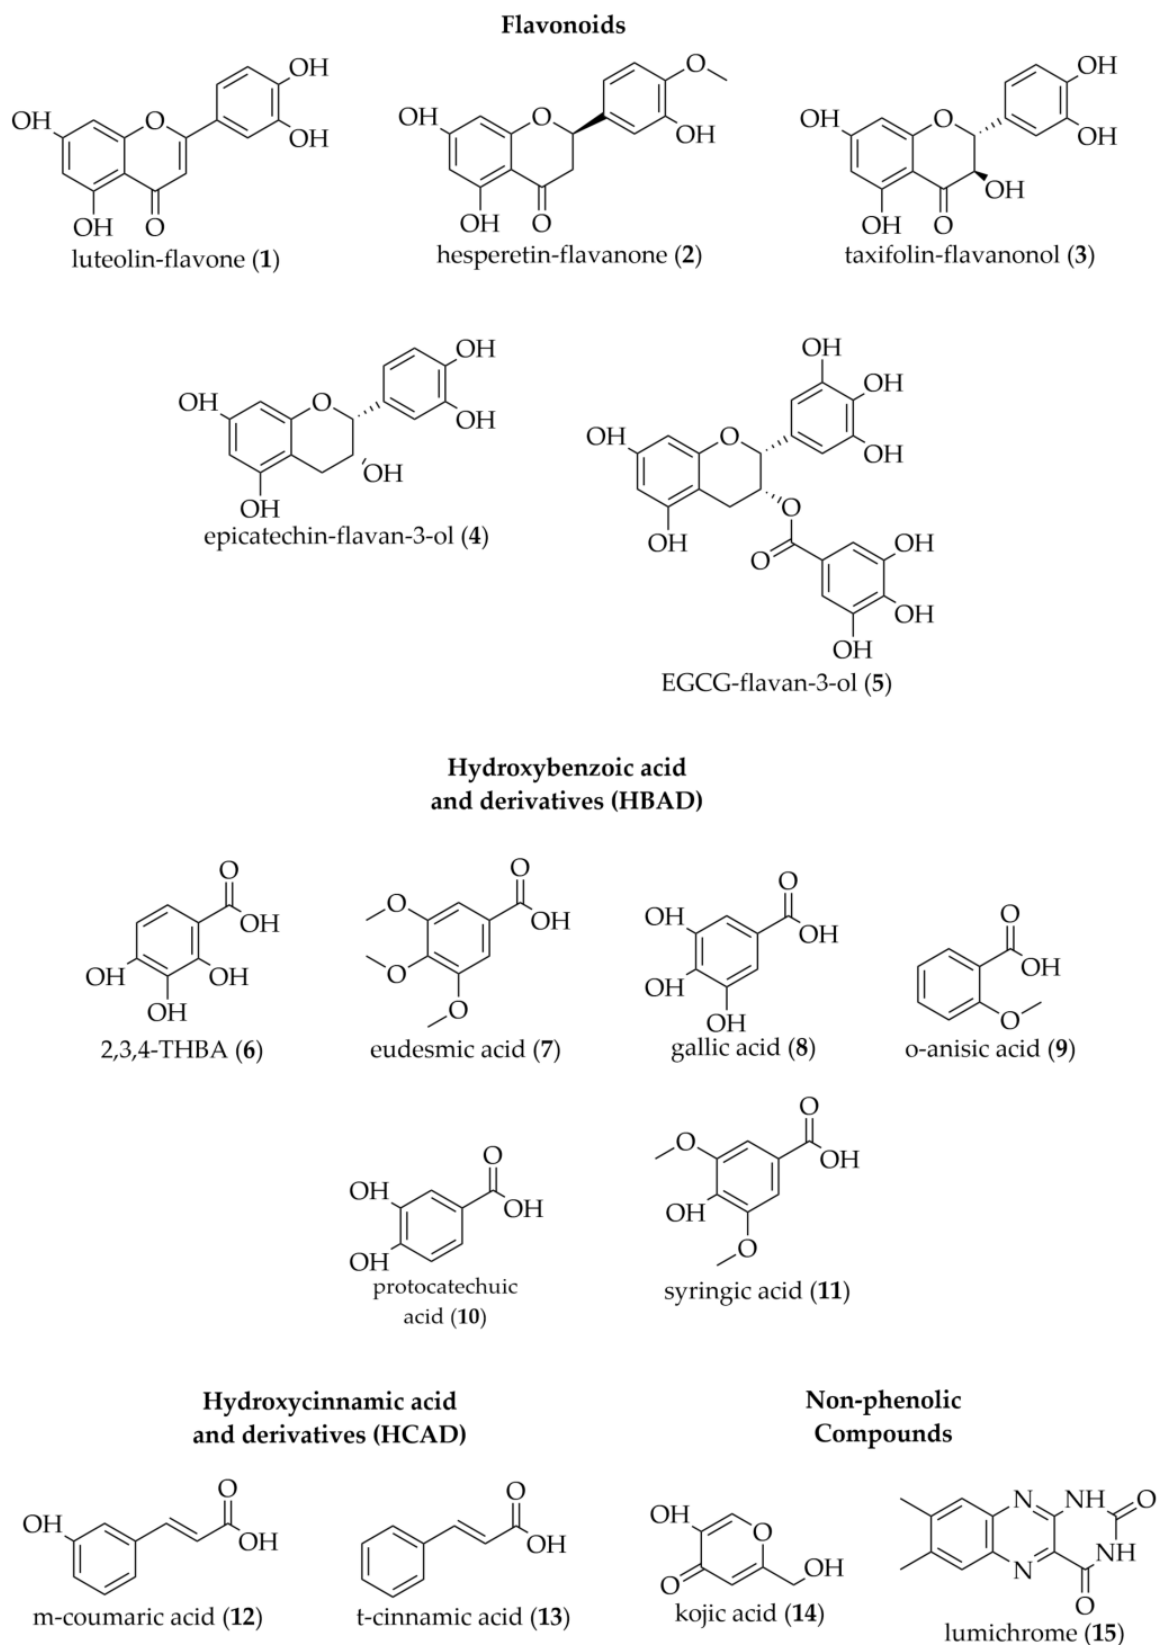
Figure 5. Structures of the compounds identified in Western Australian honeys (generated using ChemDraw version 20.1.1, PerkinElmer Informatics, Inc., Waltham, MA, USA).